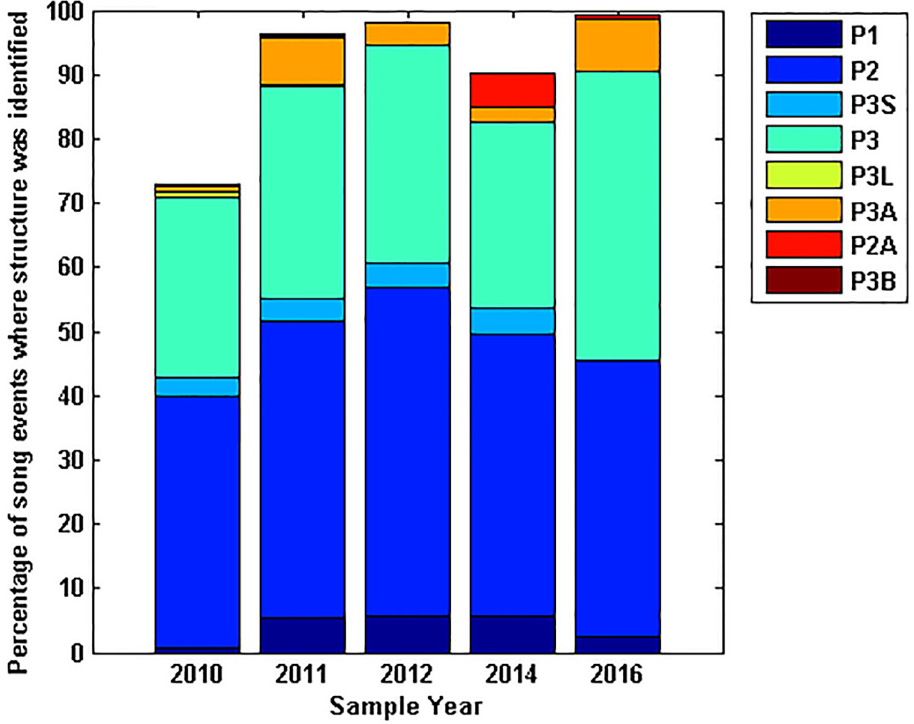
Fig 7. Proportion of song variants within a year. Distribution of song structures throughout the calendar year as a proportion of the total number of song events each month.